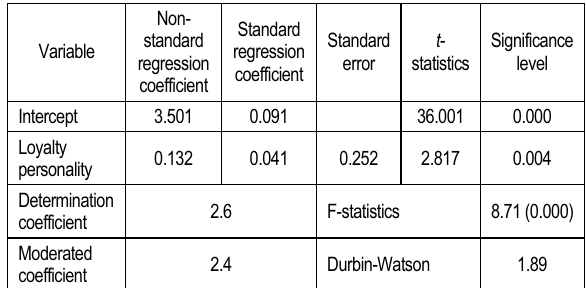
Table 5. Loyalty personality has a significant relation with career management of Melli Bank